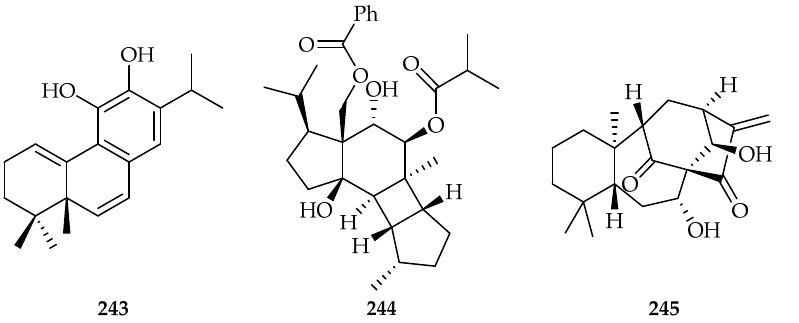
Figure 96. Structures of prattinin A 243 [150] , vulgarisin B 244 [151], and crokonoid A 245